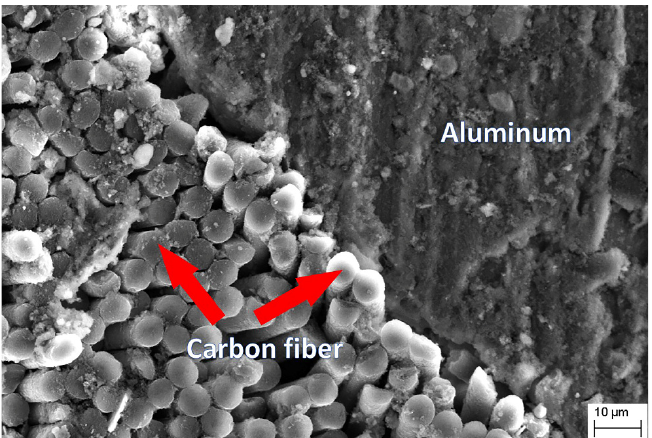
Figure 17. SEM image of the interface between carbon fiber and aluminum matrix.